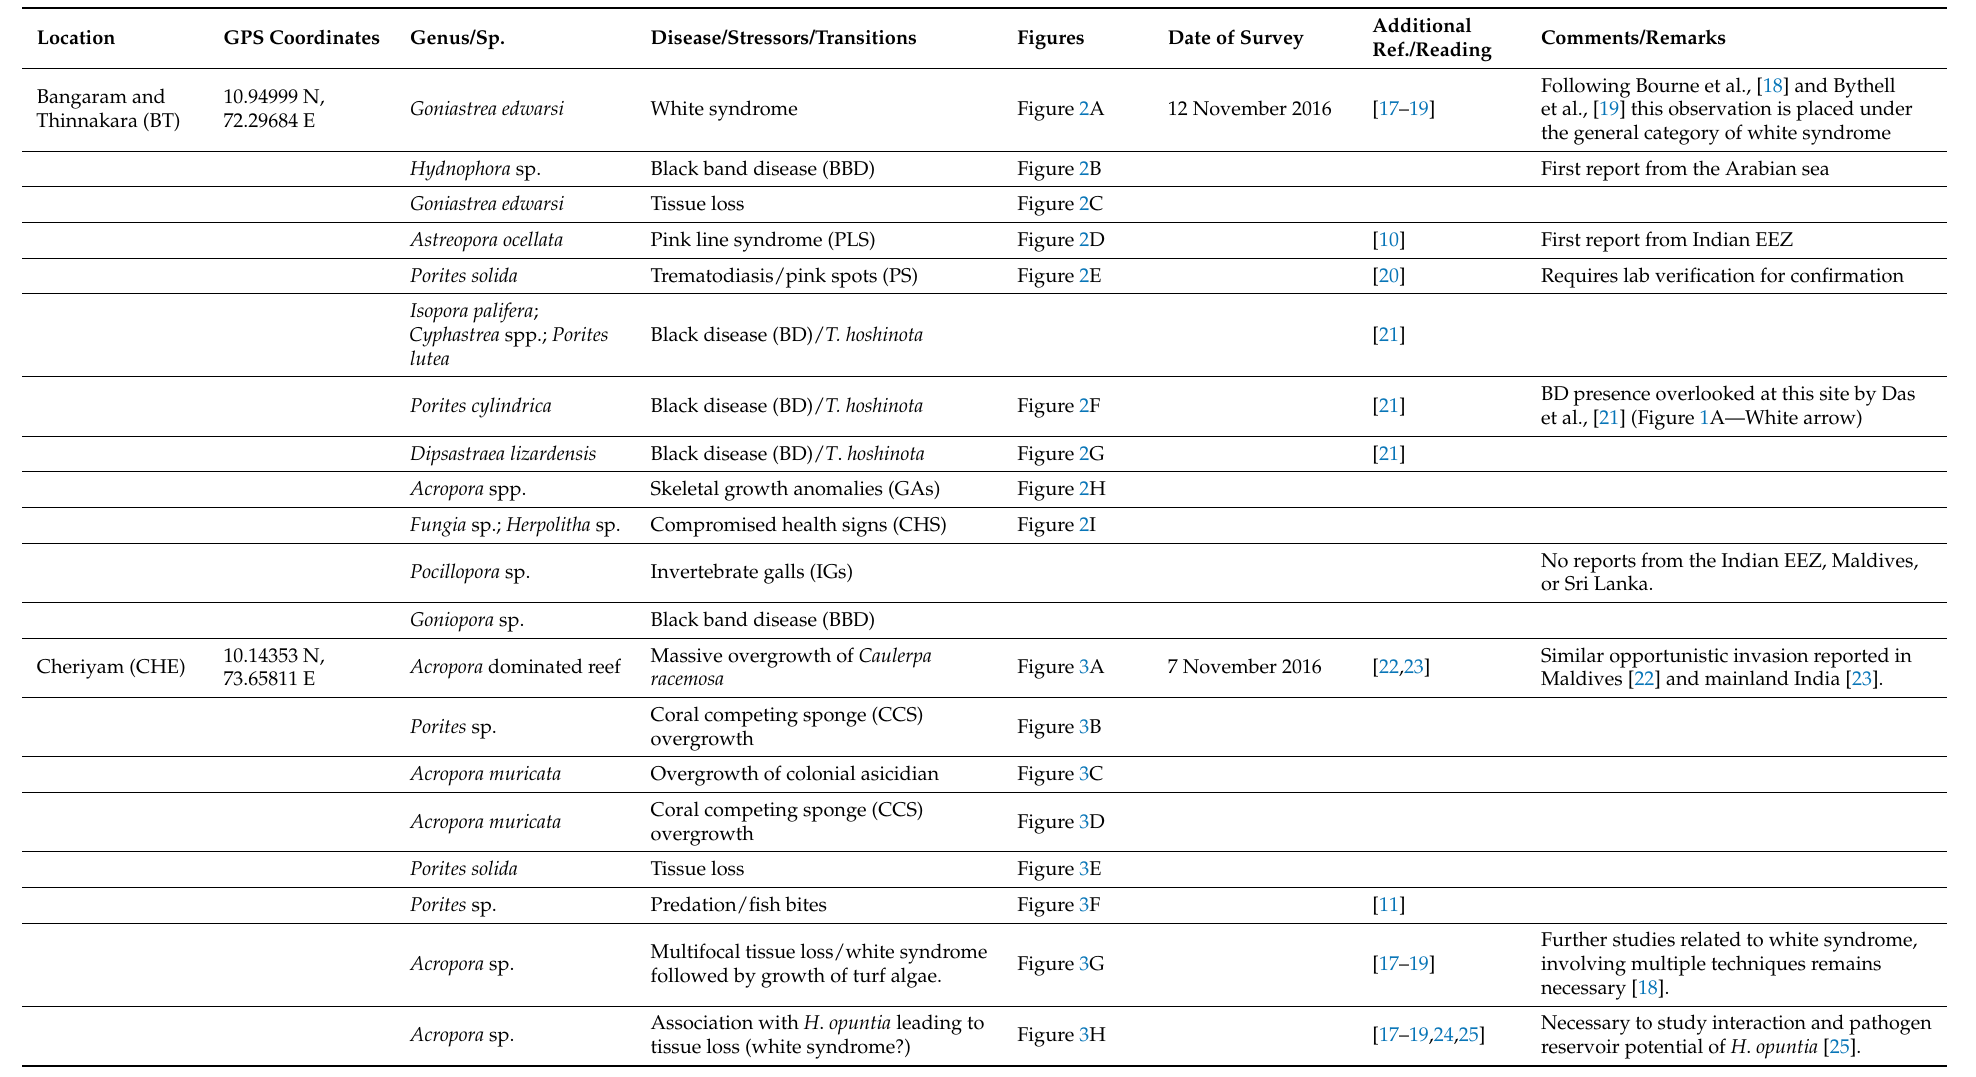
Table 2. Disease and coral health conditions observed in Lakshadweep Atolls and its associated significance.